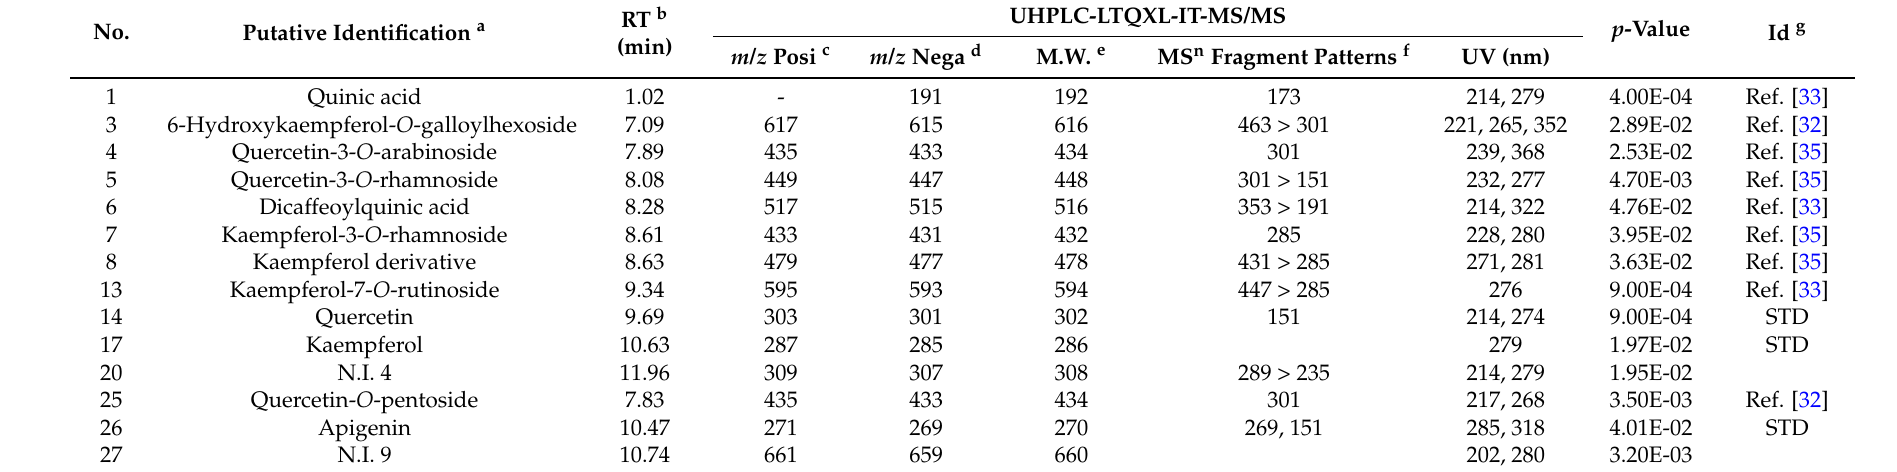
Table 2. Significantly different metabolites between Fagaceae and Asteraceae analyzed by